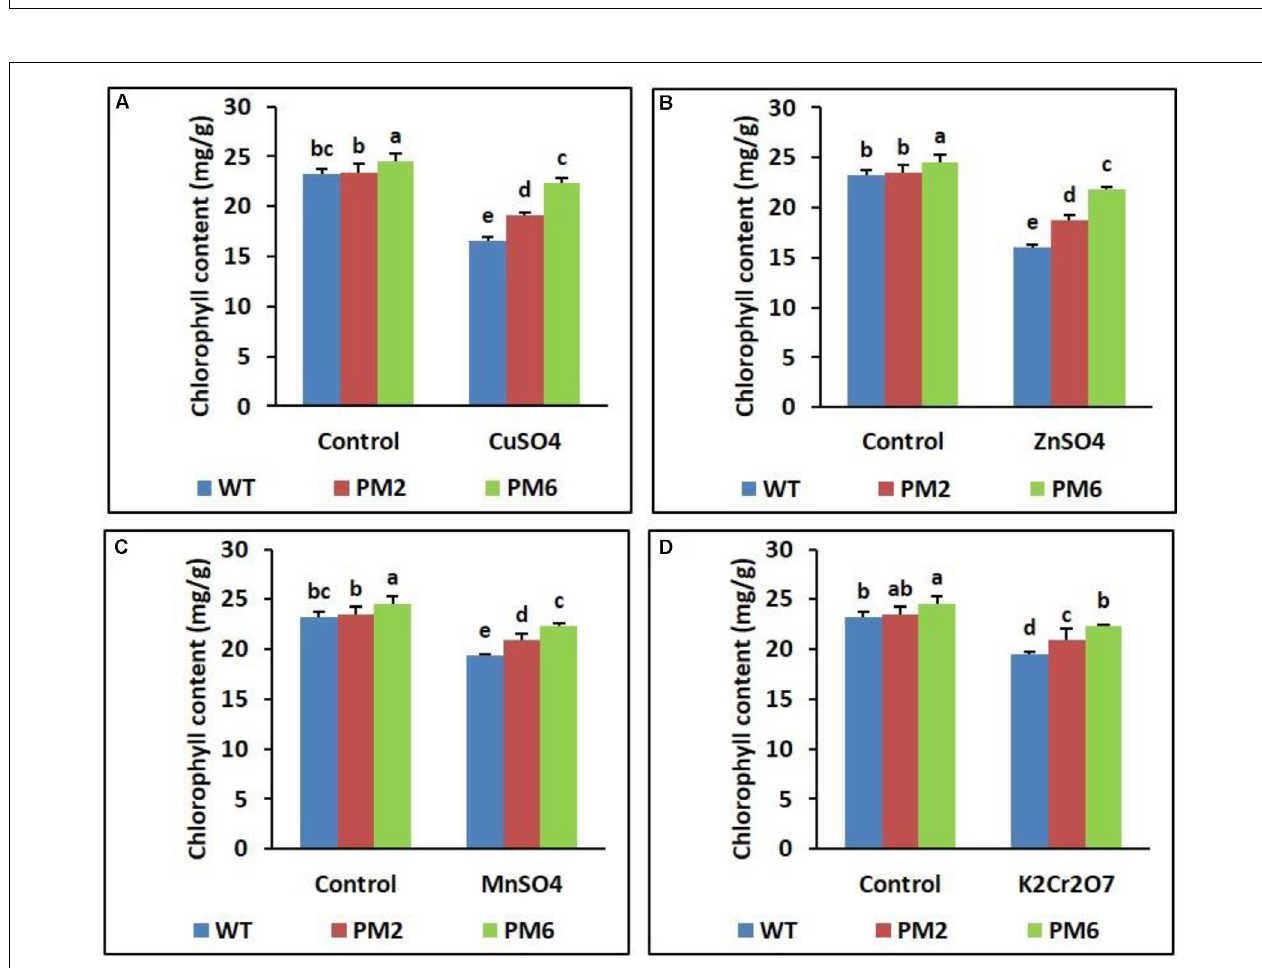
FIGURE 4 | Comparison of chlorophyll content in the T 2 -PM6, T 2 -PM2, and WT plants after exposure to the indicated heavy metals ( A , CuSO 4 ; B , ZnSO 4 ; C , MnSO 4 ; D , K 2 Cr 2 O 7 ). Data were acquired on the thirtieth day after starting the experiments. Error bars show the